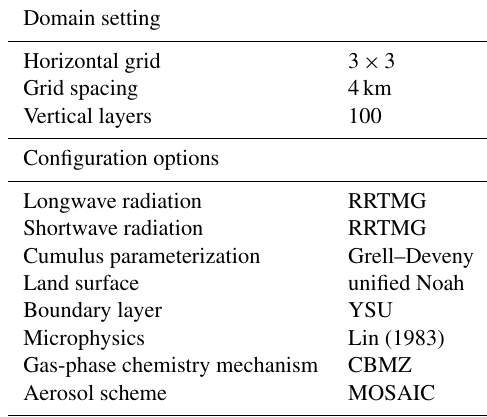
Table 1. WRF-Chem SCM model settings and configuration op-